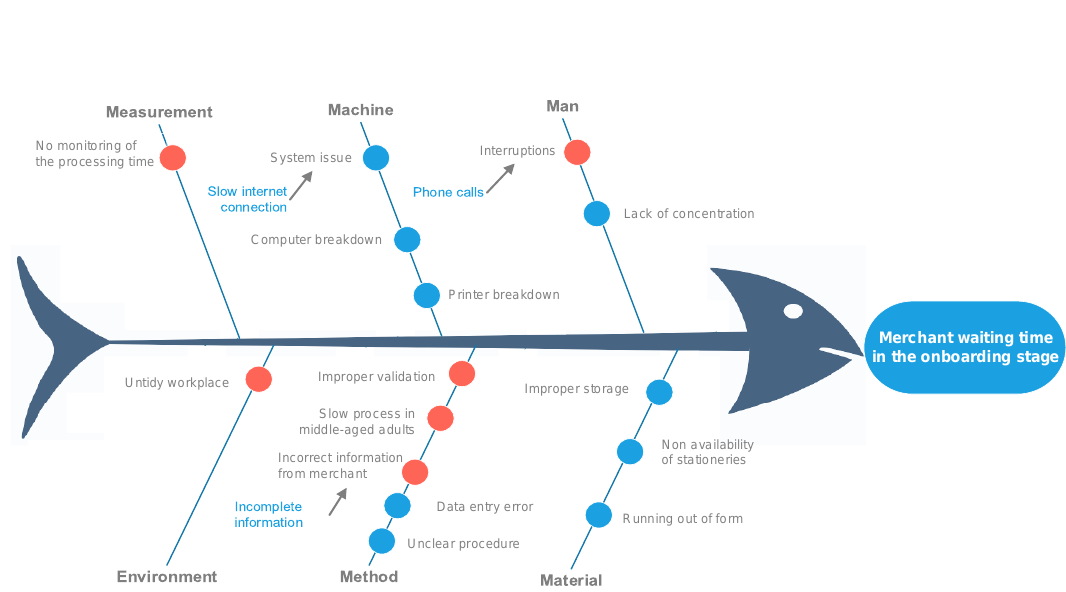
Figure 7. Cause-and-effect diagram for merchant waiting time in the onboarding